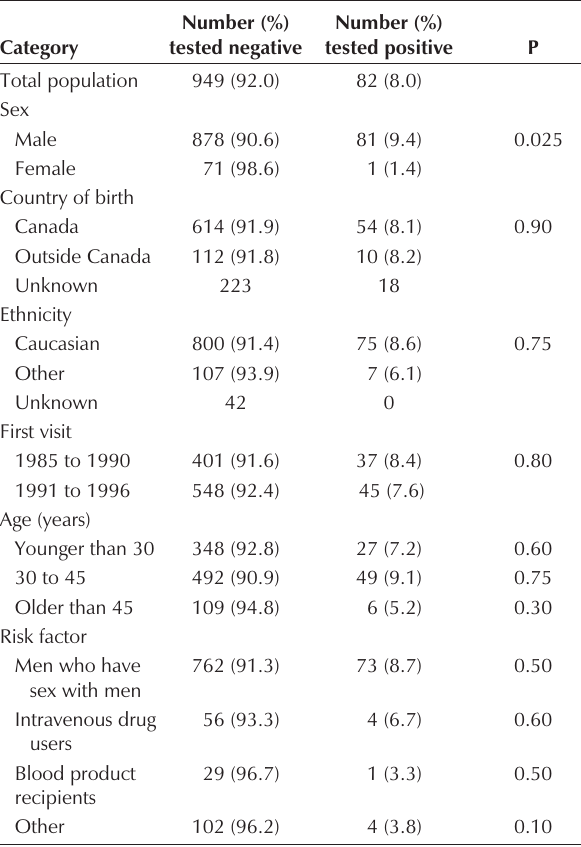
Seroprevalence of hepatitis B in a regional human immunode- ficiency virus seropositive population